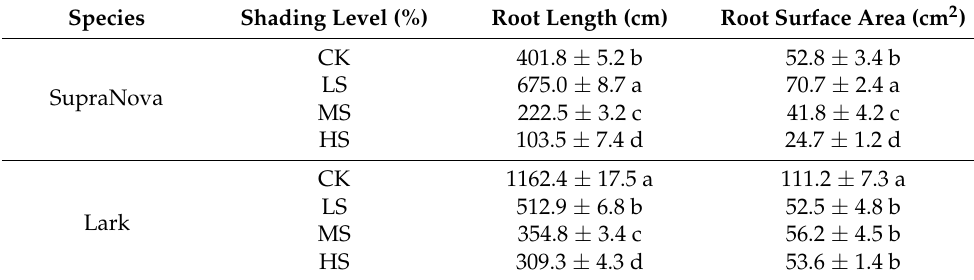
Table 2. Effects of shade on root morphology of two turfgrass